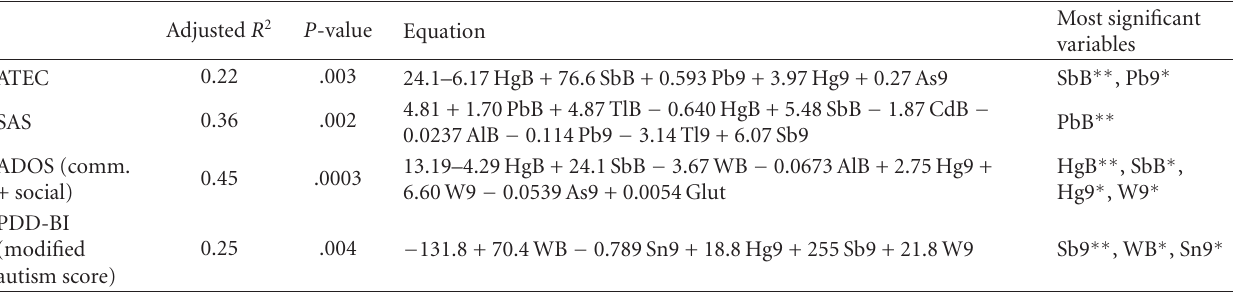
Table 5: Regression analyses of initial autism severity versus urinary metal excretion and initial glutathione. In the regression equation, the su ffi xes for the metals refer to the value at Baseline (B) and after the 9th (9) dose of DMSA in Phase 1.